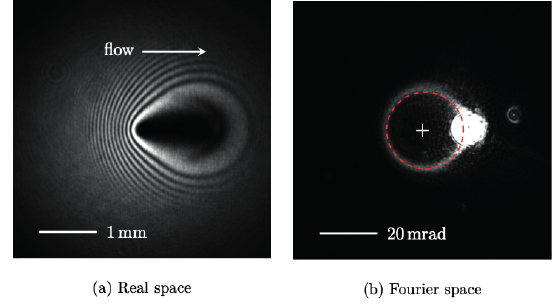
Figure 1. Scattering of the fluid on an attractive or repul- sive defect. a) Density distribution (real space imaging). b) Momentum space distribution (Fourier space imaging)